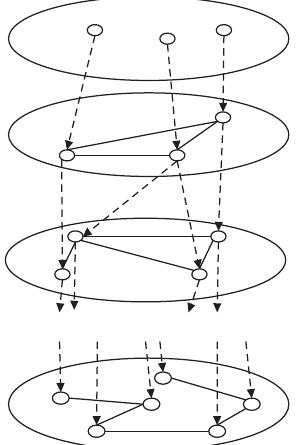
Figure 1: Hierarchical topology of information